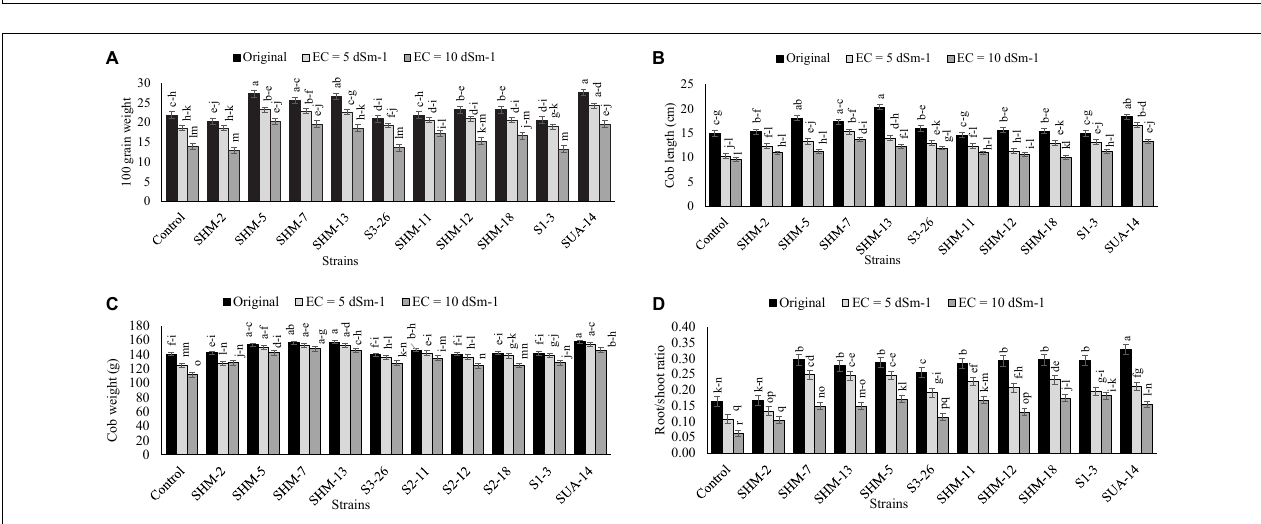
FIGURE 2 | Effect of rhizobacterial inoculation on yield parameters, i.e., (A) 100-grain weight (g), (B) Cob length (cm), (C) Cob weight (g), and (D) root/shoot ratio of maize under salt-stressed pot conditions. Bars sharing the same letters are statistically non-significant at p ≤ 0.05.